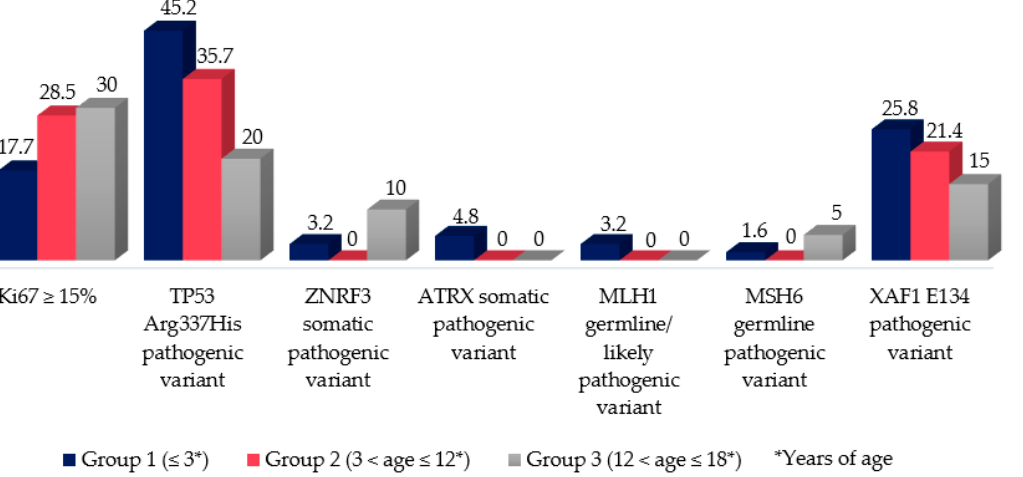
Figure 8. Percentage of patients in each age-groups in the evaluation of pediatric adrenal tumor-related genes; group 1: ≤ 3 years of age; group 2: 3 < age ≤ 12 years of age; group 3: 12 < age ≤ 18 years of age. Ki67 ≥ 15% increased the risk of developing metastasis in all groups ( p < 0.05; HR: 8.1; CI 95% 1.2–8.2). The TP53 Arg337His pathogenic variant, ZNRF3/ ATRX somatic pathogenic variant, MLH1 germline/ likely pathogenic variant, MSH6 germline pathogenic variant and XAF1 E134 pathogenic variant were not associated with a worse outcome, in all groups ( p > 0.05).